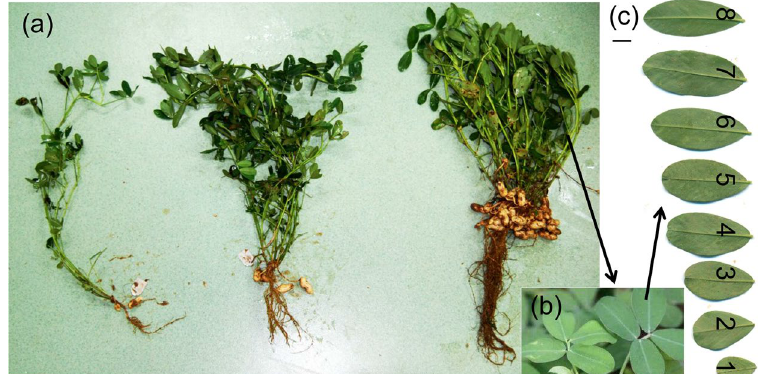
Figure 7. Morphology of whole peanut plants grown under three different light regimes (from left to right: 96% shade, 65% shade and full sun) ( a ). Arrangement and morphology of leaflets that make up the compound leaf of peanut ( b ). Morphology of apical leaflets taken from compound leaves located at nodes one through to eight (numbered from base to top) on the middle stem of a peanut plant grown under full sun ( c ). Scale bar is 1